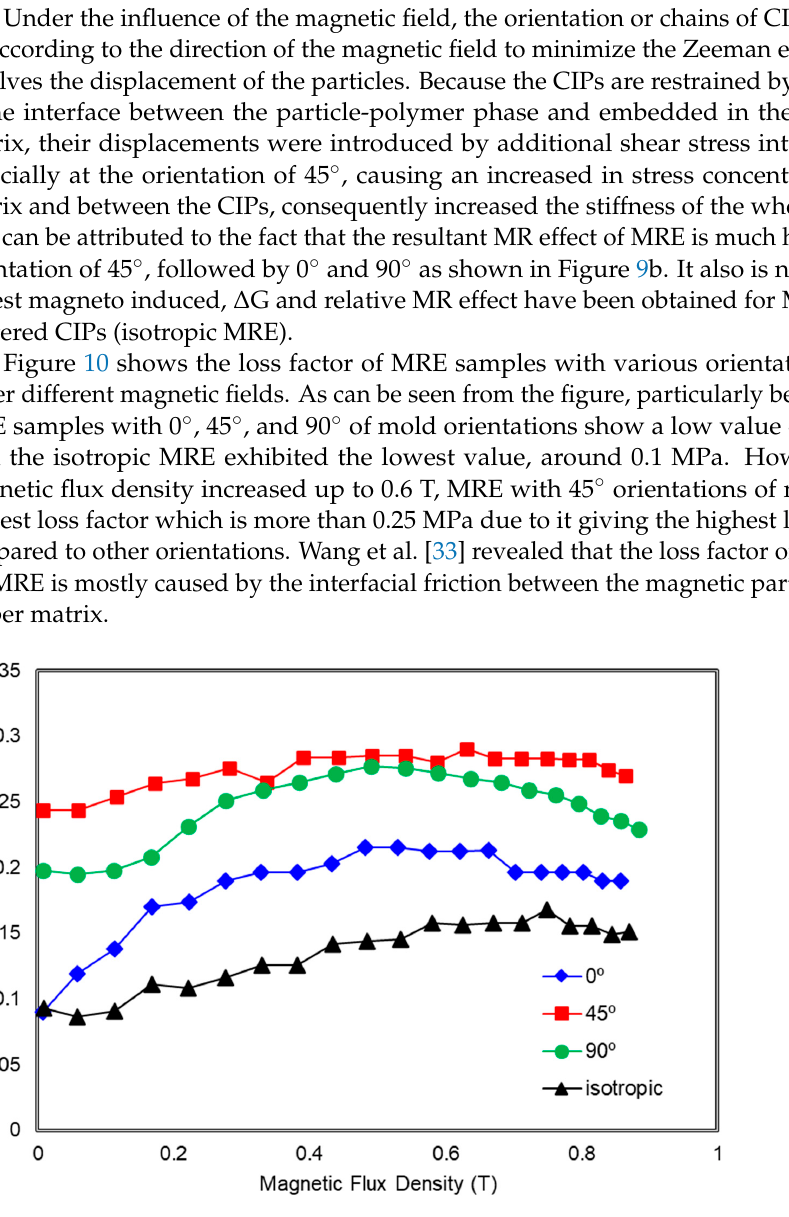
Figure 10. Loss Factor of MRE with the various orientation mold of 0°, 45°, 90° and isotropic as a function of magnetic swept.